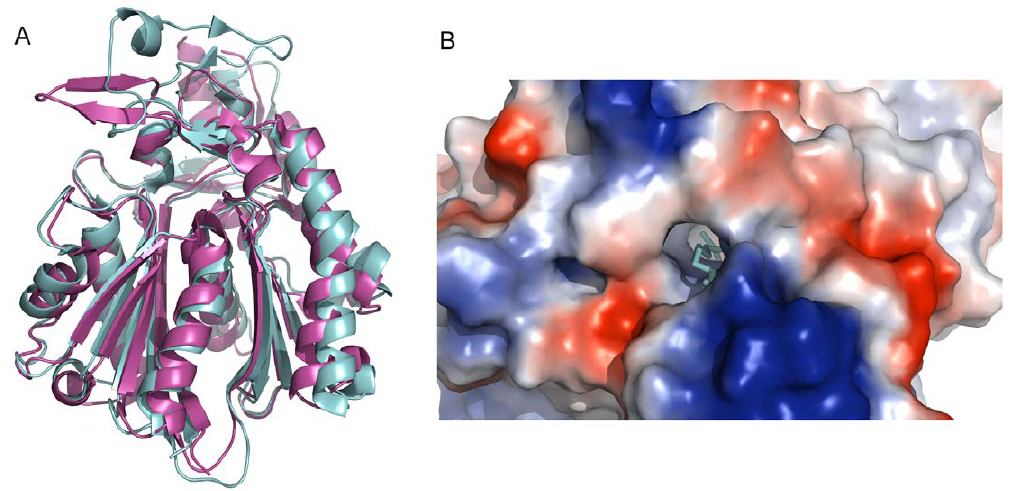
Figure 1. FabH structures from B.pseudomallei and B.xenovorans . (A) FabH (3-oxoacyl-(acyl-carrier-protein) synthase III) from B. pseudomallei 1710b (BURPS1710b_0096, PDB: 3GWA, cyan) and B. xenovorans LB400 B (Bxe_A1072, PDB: 4DFE, magenta) have similar overall structures, with a C a RMSD of 1.8 A˚ between individual chains of 3GWA and 4DFE. There is no close human homolog based on a B LAST P search of the human proteome. (B) In 4DFE, a hydrophobic tunnel to the active site is adjacent to a positively-charged surface patch (marked in blue).